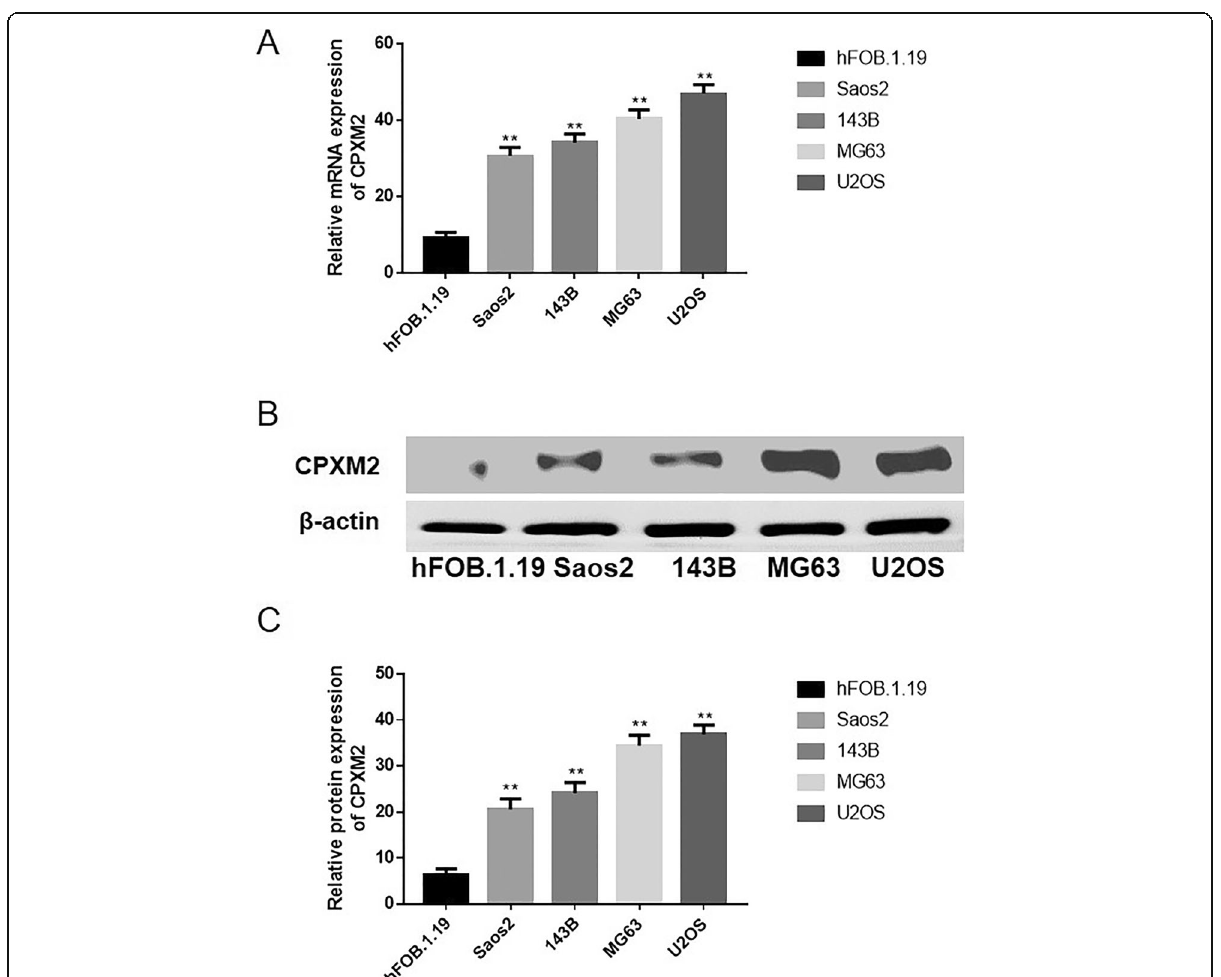
Fig. 1 Expression of CPXM2 in osteosarcoma cell lines. a Relative mRNA expression level of CDN12 in osteosarcoma cell lines versus fetal osteoblast cells. b Protein expression of CPXM2 in and osteosarcoma cell lines versus fetal osteoblast cells. c The relative protein expression of CPXM2 in and osteosarcoma cell lines versus fetal osteoblast cells. ** P < 0.01 vs. fetal osteoblast cells. OS, osteosarcoma; CPXM2, Carboxypeptidase X, M14 family member